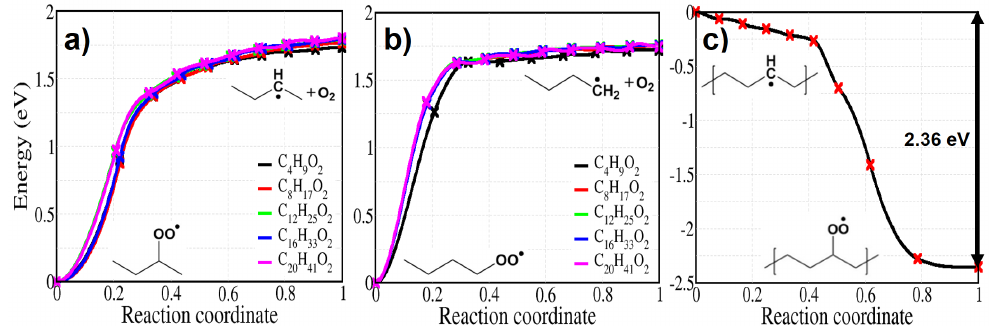
Figure 3. The capture of an oxygen molecule by an alkyl radical occurs spontaneously, as shown by the energy profiles shown here: ( a ) capture by an alkyl radical situated on a internal carbon on alkane molecules of varying length ( b ) capture by an alkyl radical situated on an end-chain carbon of alkane molecules of varying length ( c ) capture by an alkyl radical in a crystalline region of PE.